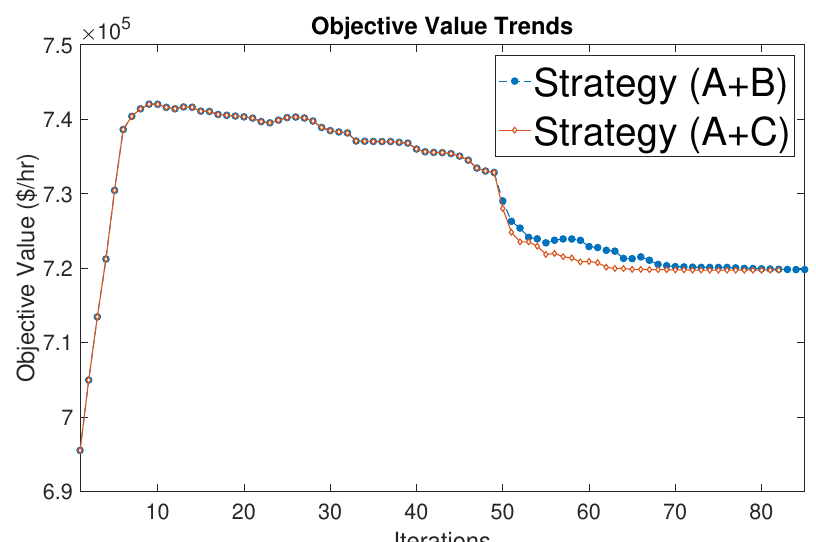
Figure 7. The 300 bus objective value. Regionalization strategies generated by AR and denote TBS-AR as strategy A, MBS-AR as B and WMBS-AR as C. Strategy A+B (blue line) is the combination of regionalization strategies A and B, Strategy A+C (red line) is the combination of regionalization strategies A and C.